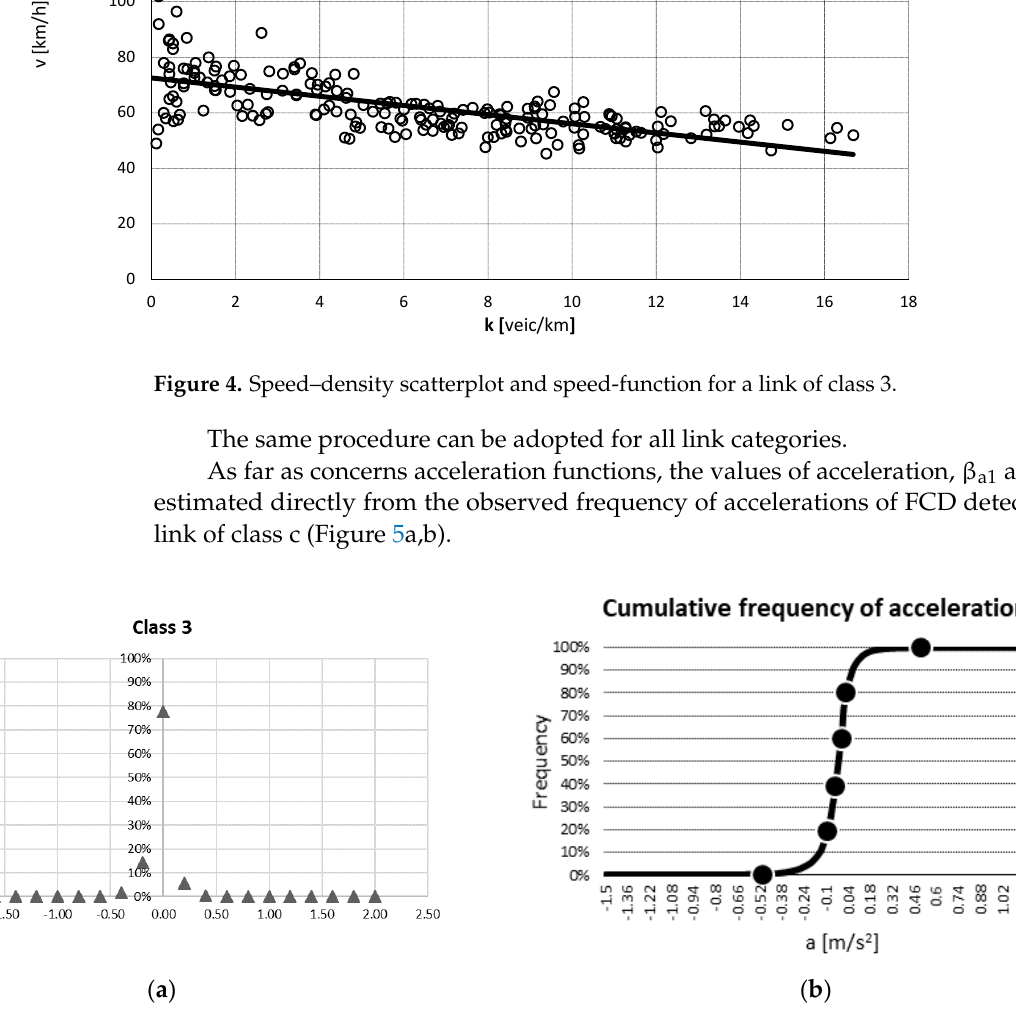
Figure 5. Relative ( a ) and cumulative ( b ) frequency of FCD vehicle accelerations for one link class, considered as an example